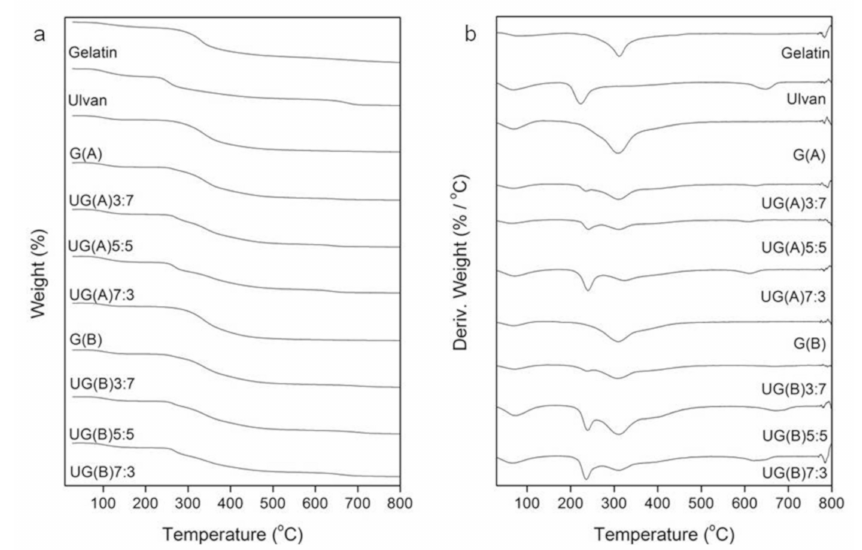
Figure 4. ( a ) TGA and ( b ) DTG thermogravimetric curves of gelatin, ulvan, and UG sca ff